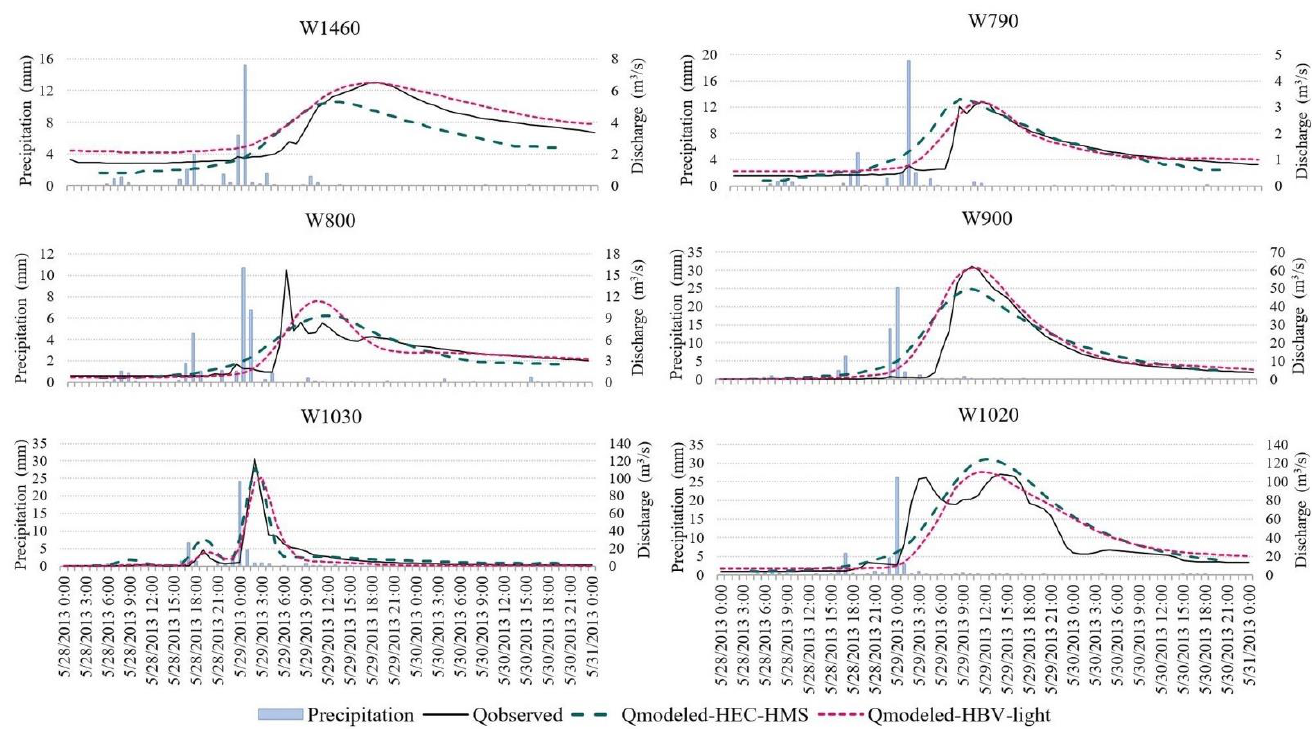
Figure 3. Precipitation, observed and modeled discharge of the 28 – 30 May 2013 rain event at the six gauged stations.